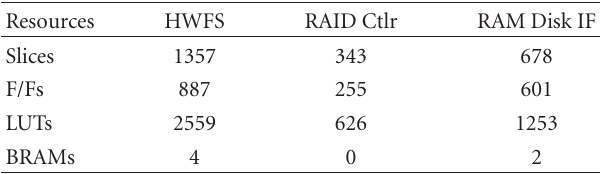
Table 2: Hardware filesystem with a single disk resource utilization synthesized for the XC4VFX60.